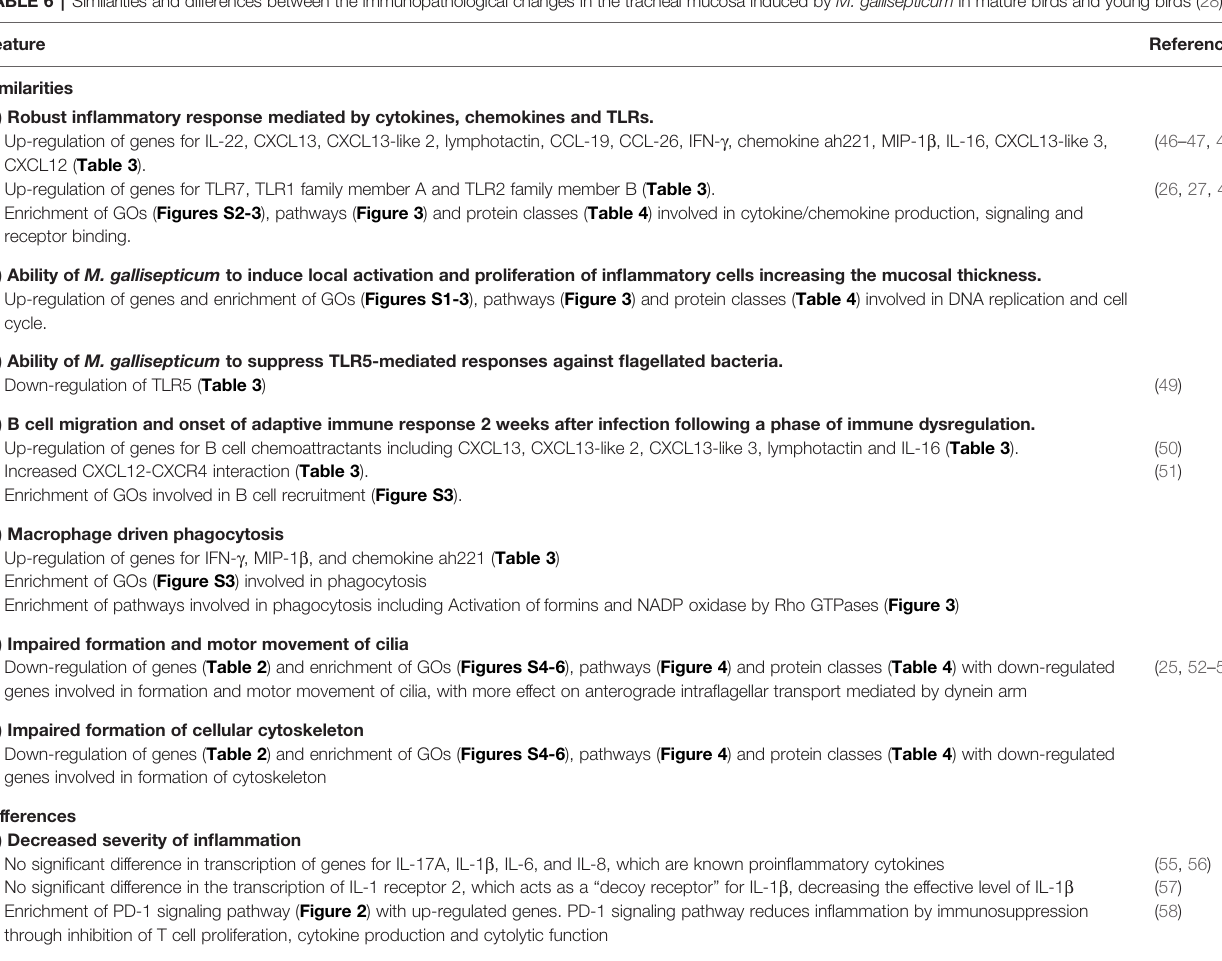
TABLE 6 | Similarities and differences between the immunopathological changes in the tracheal mucosa induced by M. gallisepticum in mature birds and young birds